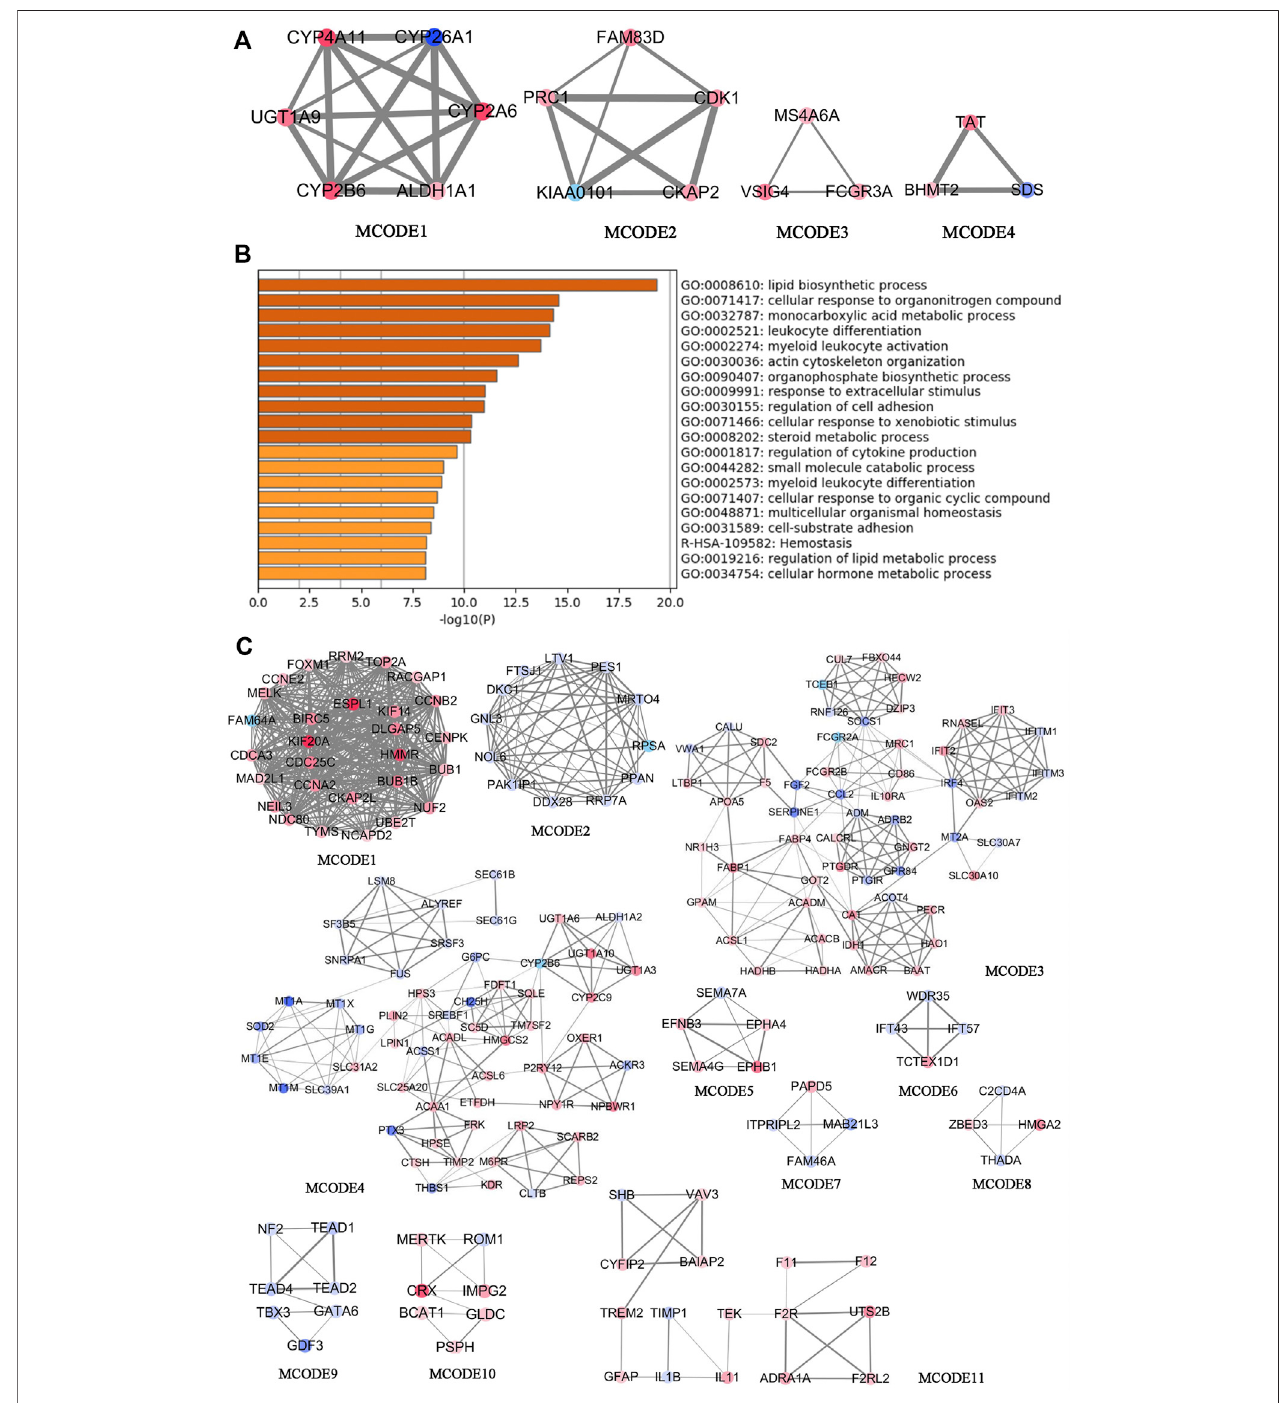
FIGURE 4 | Comprehensive analysis of differentially expressed genes in the transcriptomic analysis of patients with MAFLD vs. control subjects using Metascape and Cytoscape. (A) The four signi fi cant MCODE components form the PPI network of overlapping genes. (B) Bar graphs showing the top 20 signi fi cantly enriched biological processes and pathways associated with MAFLD differently expressed genes excluding overlapping genes. (C) The top 11 signi fi cant MCODE components from the PPI network of MAFLD differently expressed genes excluding overlapping genes. The MCODE algorithm was applied to this network to identify neighborhoodswhereproteinsaredenselyconnected.Eachnoderepresentsaprotein,andtheedgebetweennodesrepresentstheinteractionbetweentwoconnected proteins.